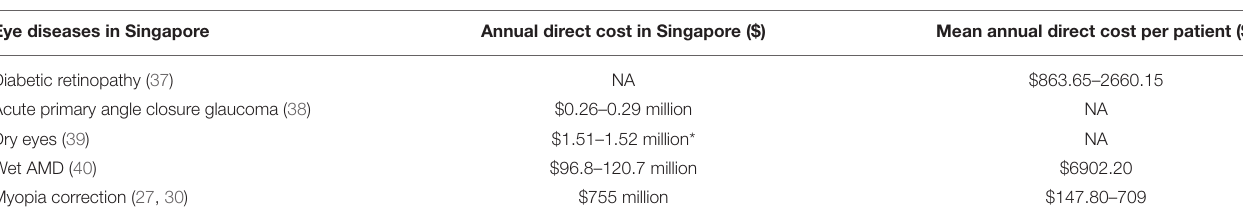
TABLE 2 | Cost of ocular diseases in